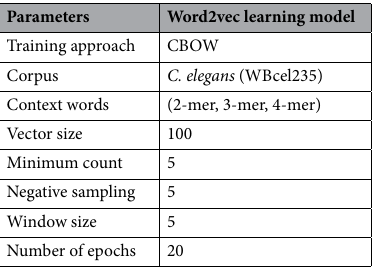
Table 1. Parameters of word2vec model which were used in training.